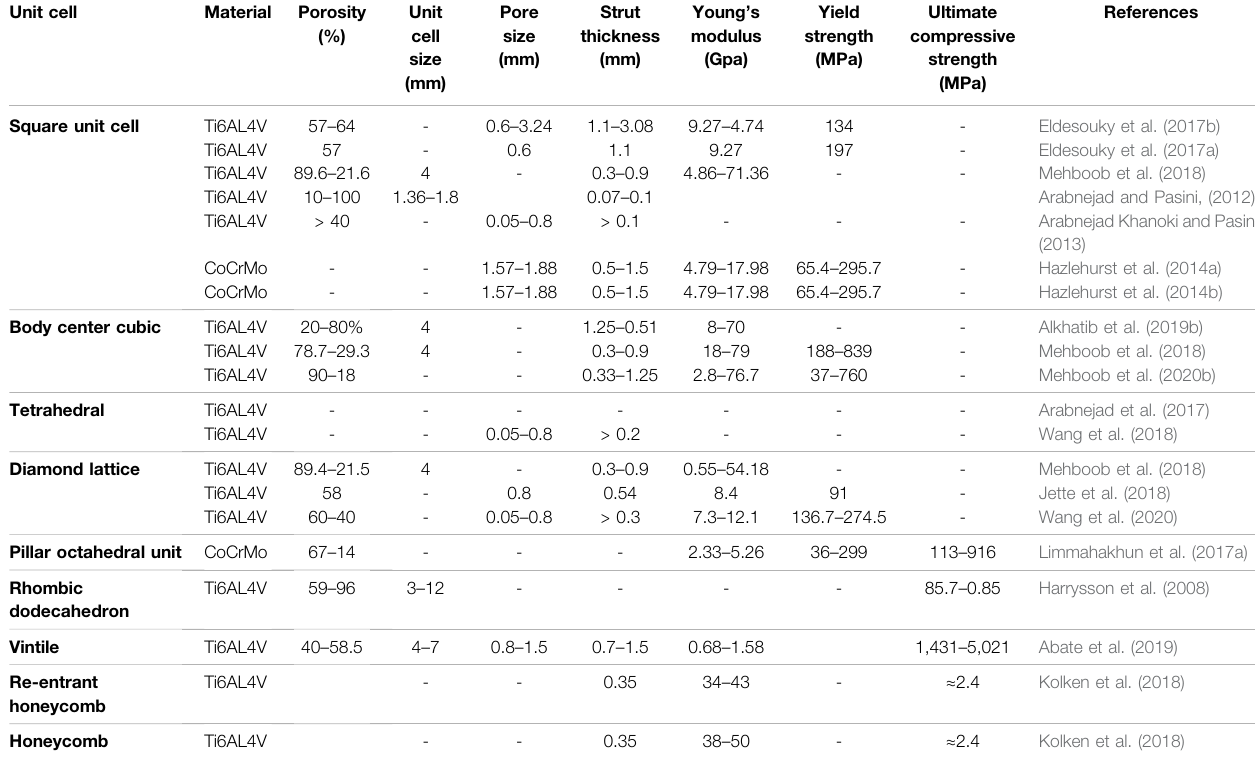
TABLE 1 | Geometric features and mechanical properties of different regular porous structures applied to femoral